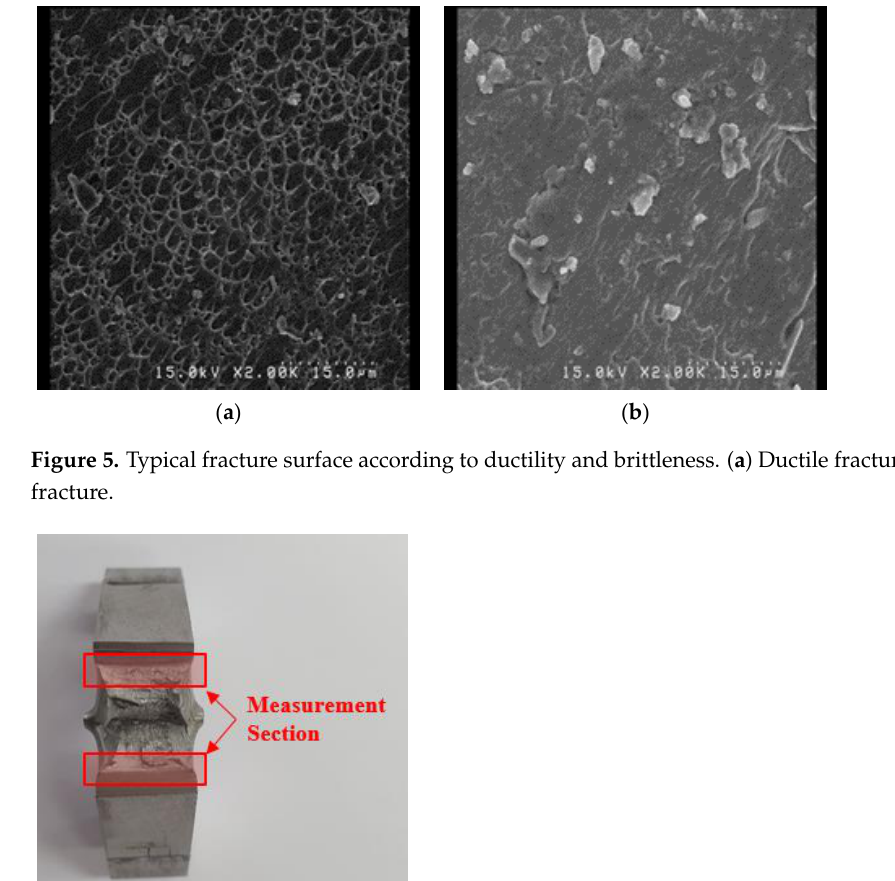
Figure 6. Definition of measurement section for impact specimens.